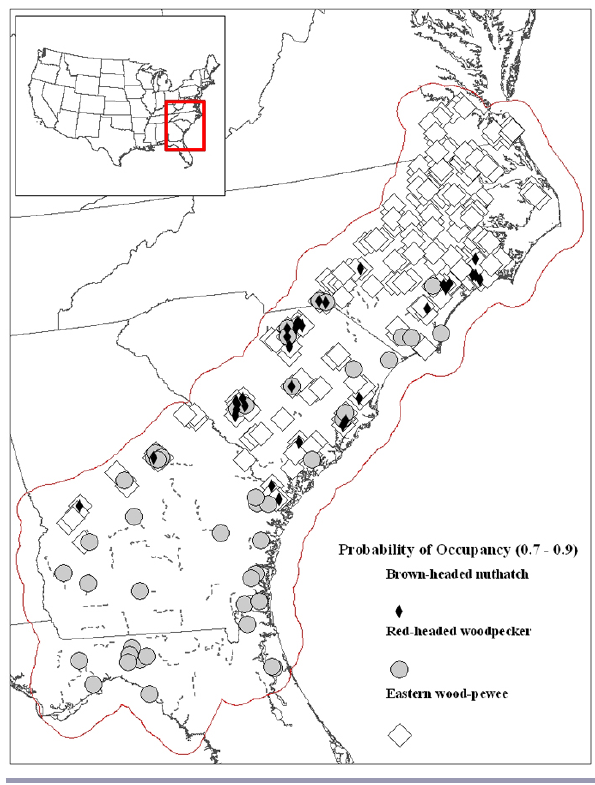
Fig. 2 . Location of route segments with high probabilities of occupancy (0.7 – 0.9) for the Brown-headed Nuthatch ( Sitta pusilla ), Eastern Wood-pewee ( Contopus virens ), and Red-headed Woodpecker ( Melanerpes erythrocephalus ) in the South Atlantic Coastal Plain, United States, 2001. Occupancy was modeled as a function of the amount of optimal habitat (marginal for the woodpecker; Hamel 1992) and latitude. Latitude was a categorical covariate (LatS = 29-31°, LatC = 32-34°N, LatN = 35-37°N); 400 m is the width of survey routes. Models account for probability of species detection and spatial correlation within segments